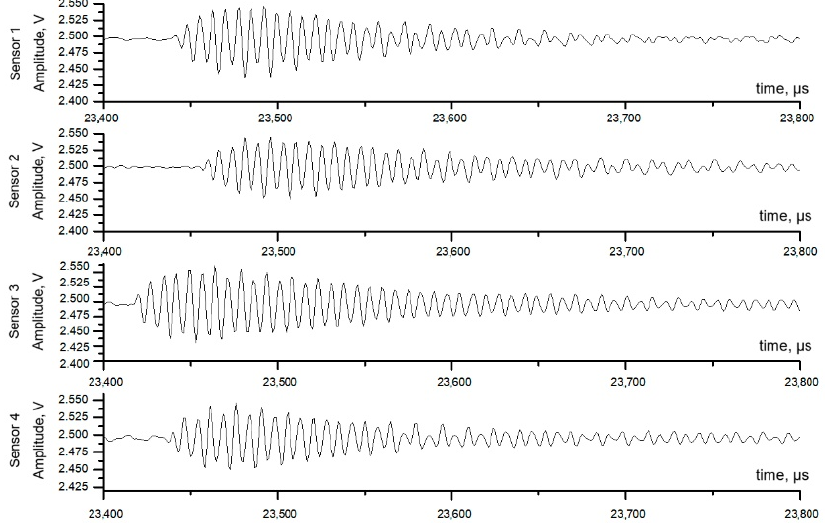
Figure 7. The signal of one PD received by each ultrasonic receiver of the microphone array. The PD signal recorded by the EM sensor is shown in Figure 8.